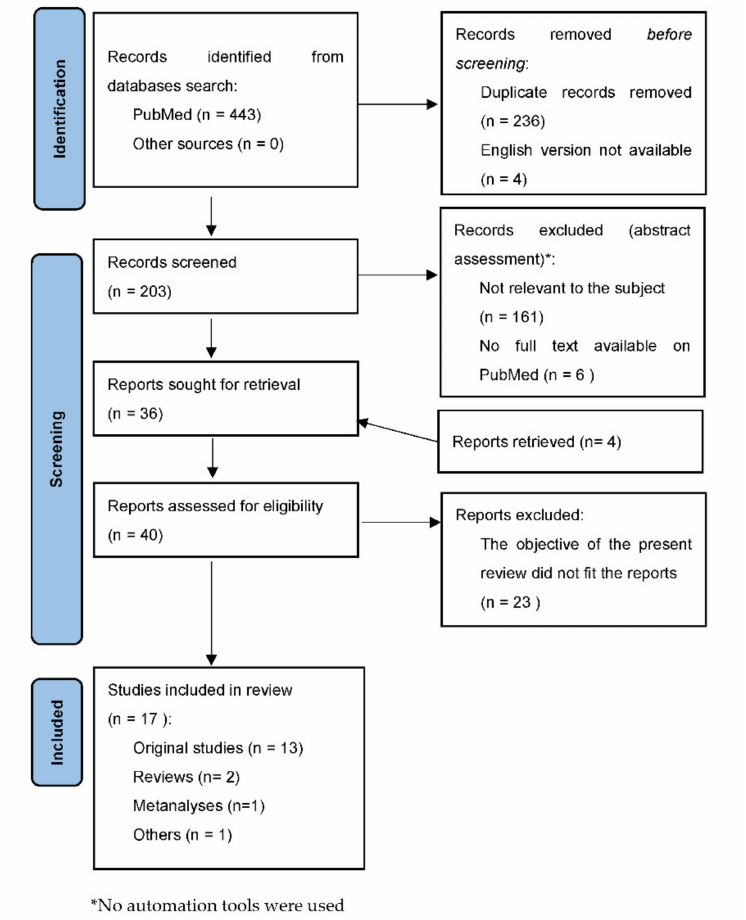
Figure 1. Flow chart of the search and selection of the literature